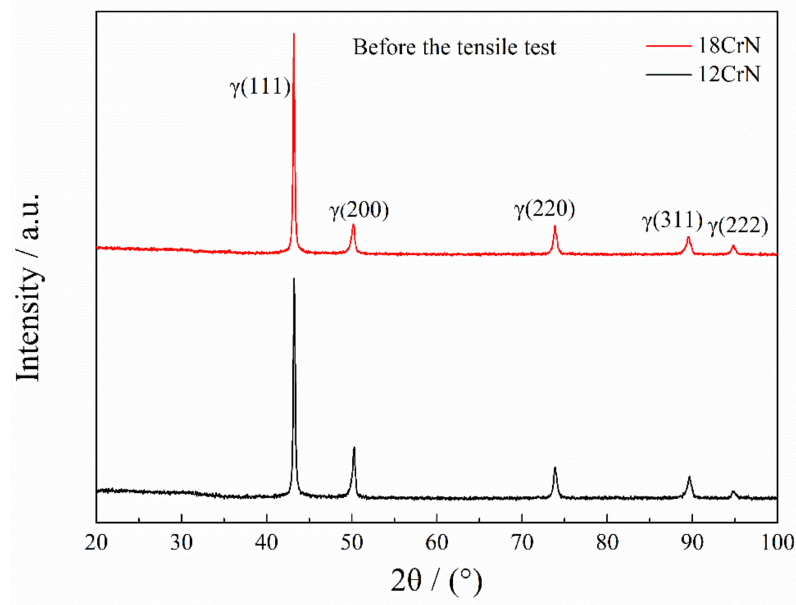
Figure 1. XRD patterns of Fe–Mn–Cr–CN TWIP steels before the tensile test.